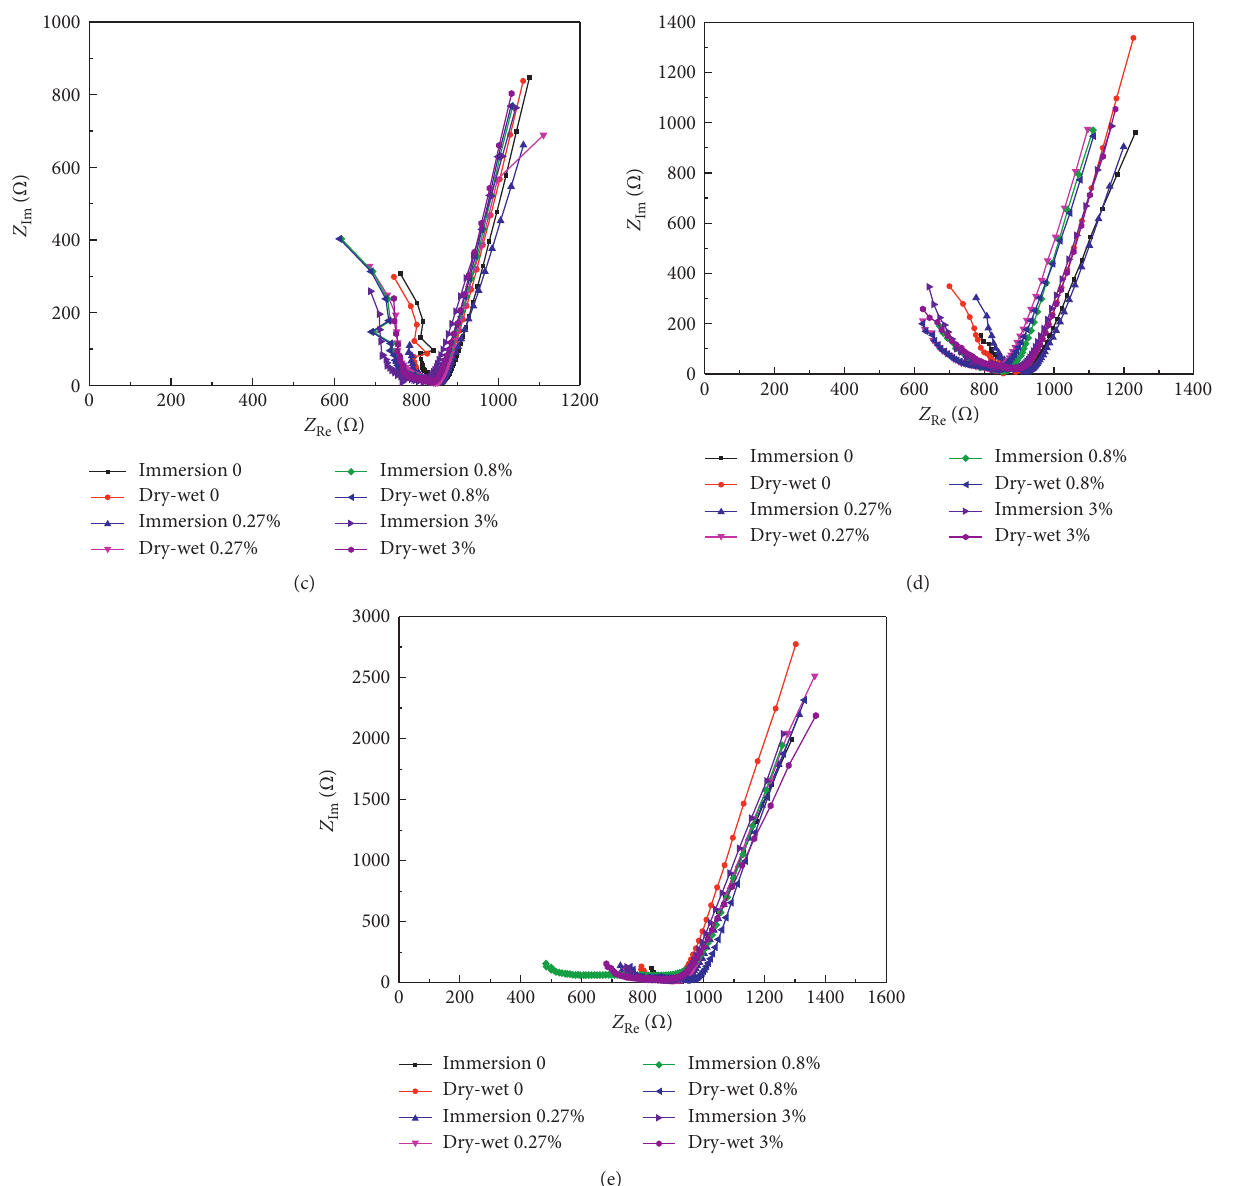
Figure 8: Nyquist diagram of reinforcement for flexural specimens at each age: (a) 60 days, (b) 120 days, (c) 180 days, (d) 240 days, and (e) 300